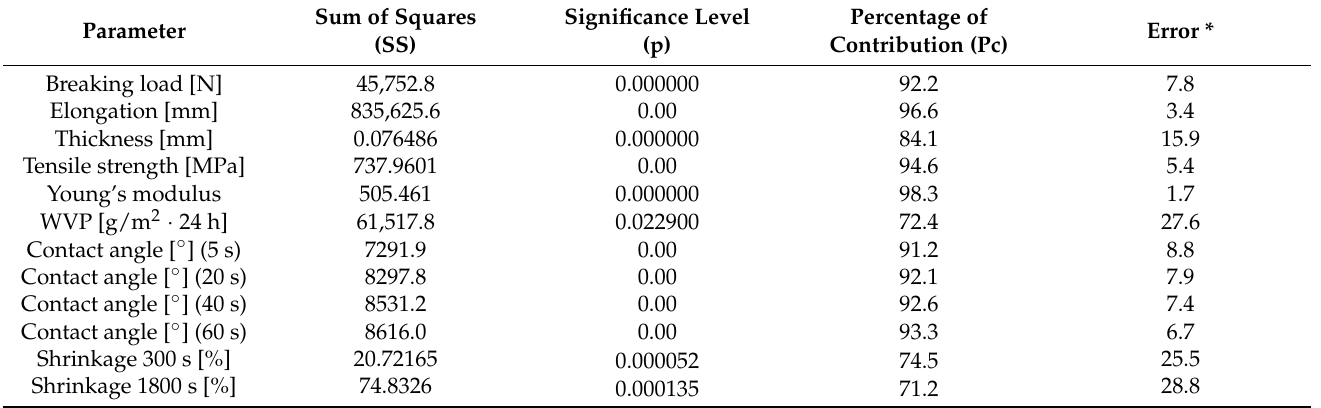
Table 2. Analysis of the variance of the influence of formulation of tested membranes on individual properties.